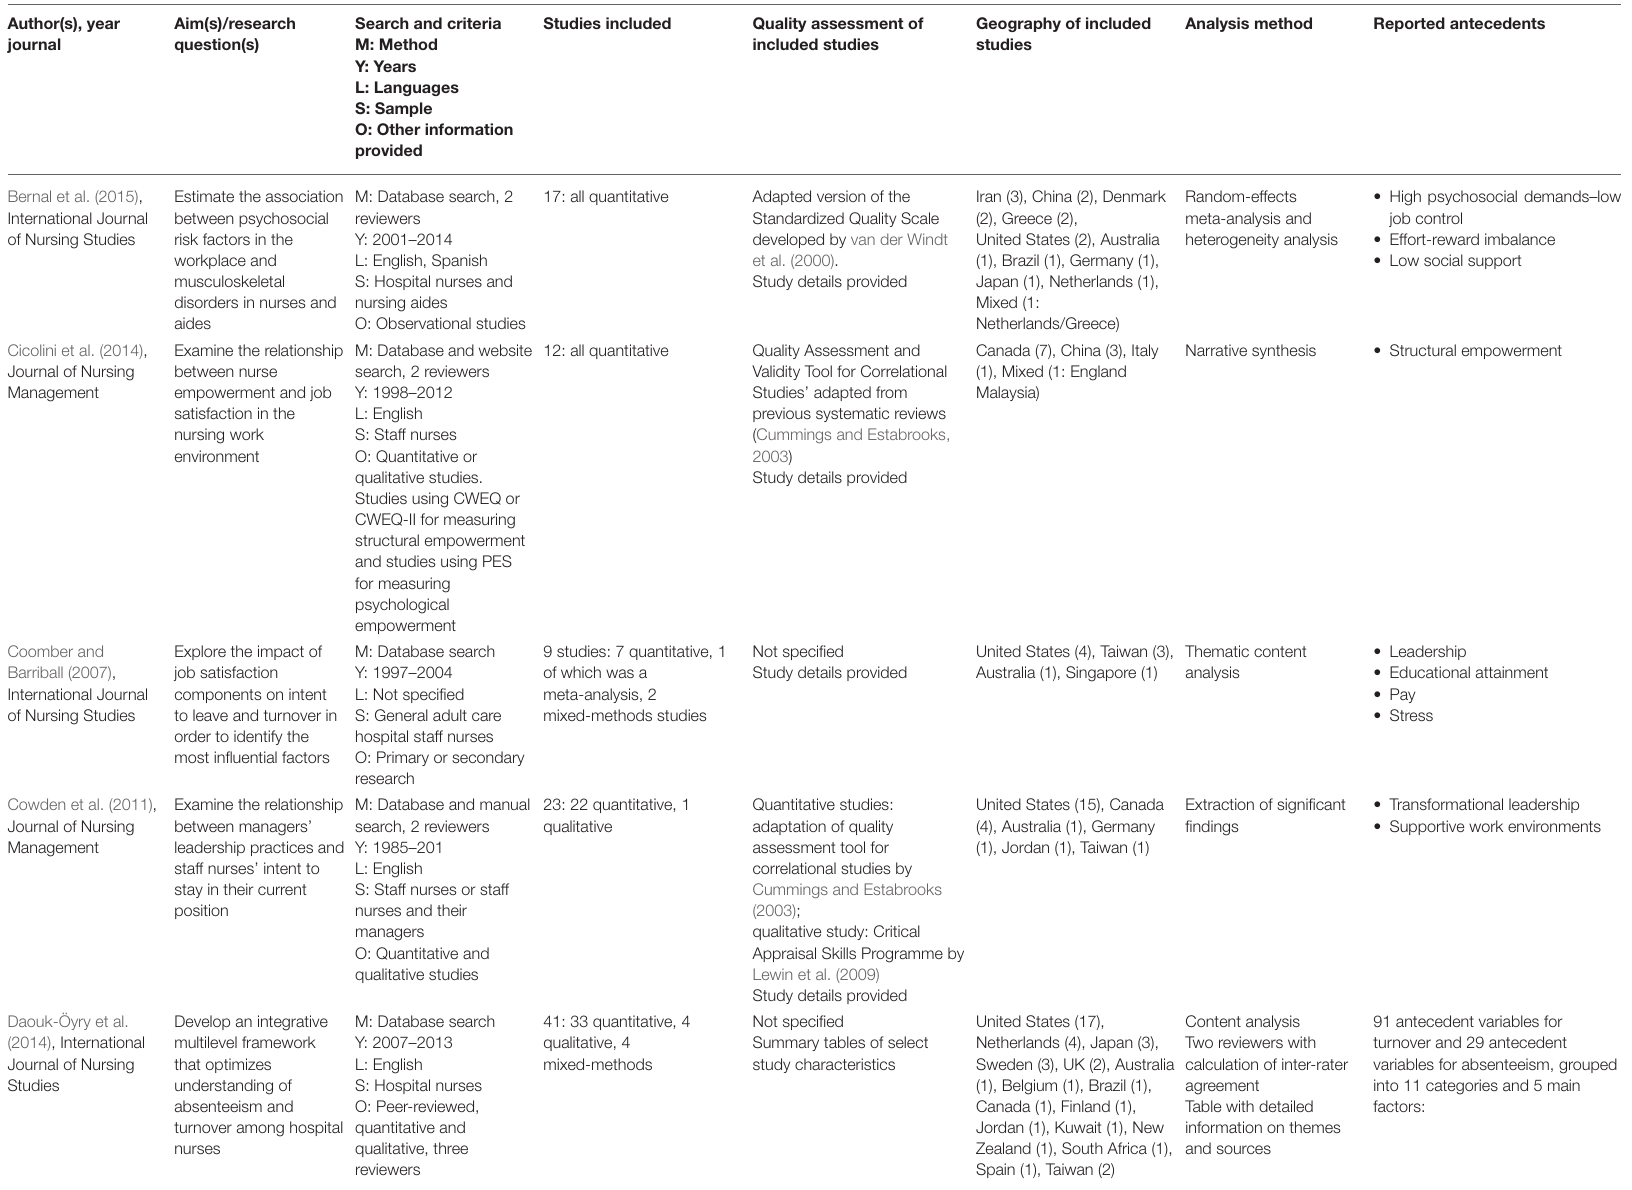
TABLE 2 | Characteristics of the included